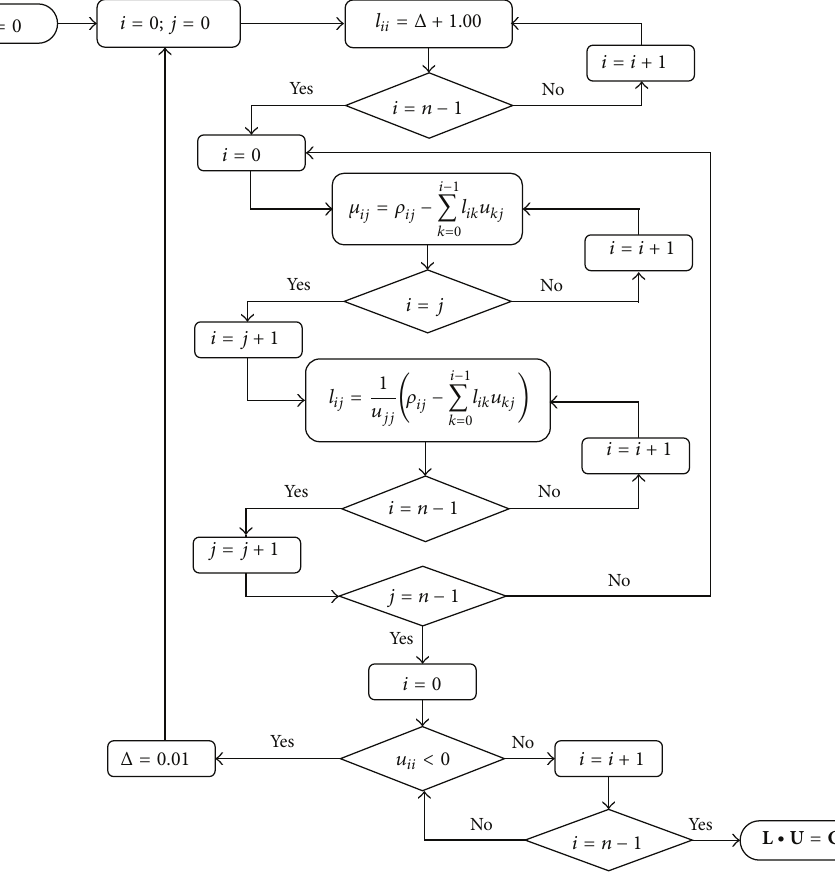
Figure 9: Flow diagram detailing the sequence of processes for the extended Crout’s